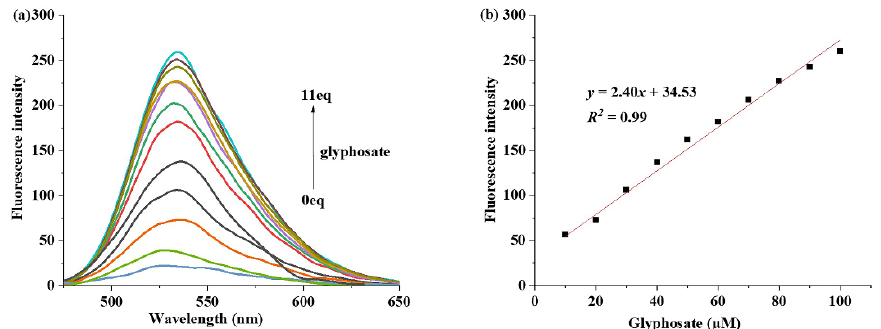
Figure 7. ( a ) Fluorescence spectrum of NPA−Cu 2+ on the addition of different amount of glyphosate